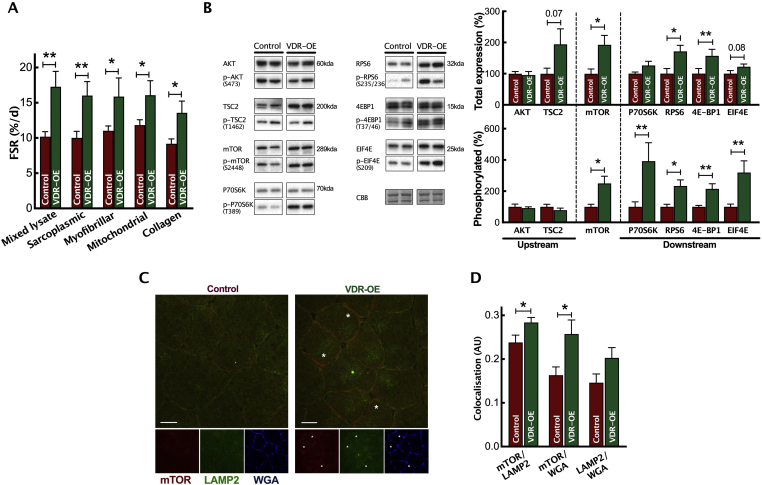
In vivo VDR-OE increases anabolic signalling and translational efficiency. (A) Measurement of MPS rates of mixed lysate, sarcoplasmic, myofibrillar, mitochondrial and collagen protein subfractions by D2O incorporation (n = 7). (B) Representative western blots and quantification of phosphorylated and total protein anabolic signalling intermediates (n = 7). CBB, Coomassie Brillian Blue. (C) Representative images of mTOR and LAMP2 co-localisation. (D) Quantification of mTOR and LAMP2 co-localisation (n = 7). Data are mean ± SEM. ∗p < 0.05, ∗∗p < 0.01 between indicated groups. (For interpretation of the references to color in this figure legend, the reader is referred to the Web version of this article.)